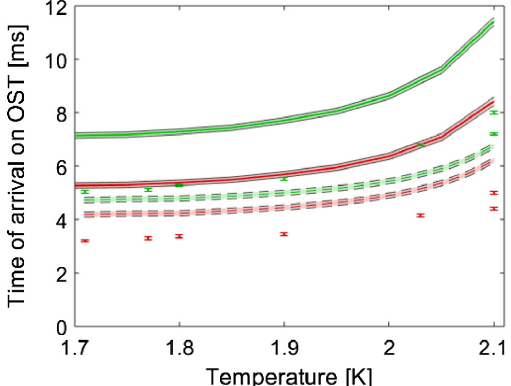
FIG. 18. Time of arrival on first (red) and second (green) OST with varying temperature for Test 4 (cavity B). Experimental data (points with error bars), calculated data with direct line of sight propagation (solid line) and with niobium-helium transport model (dashed line). The shaded area represent the error on calculation due to geometrical measurements